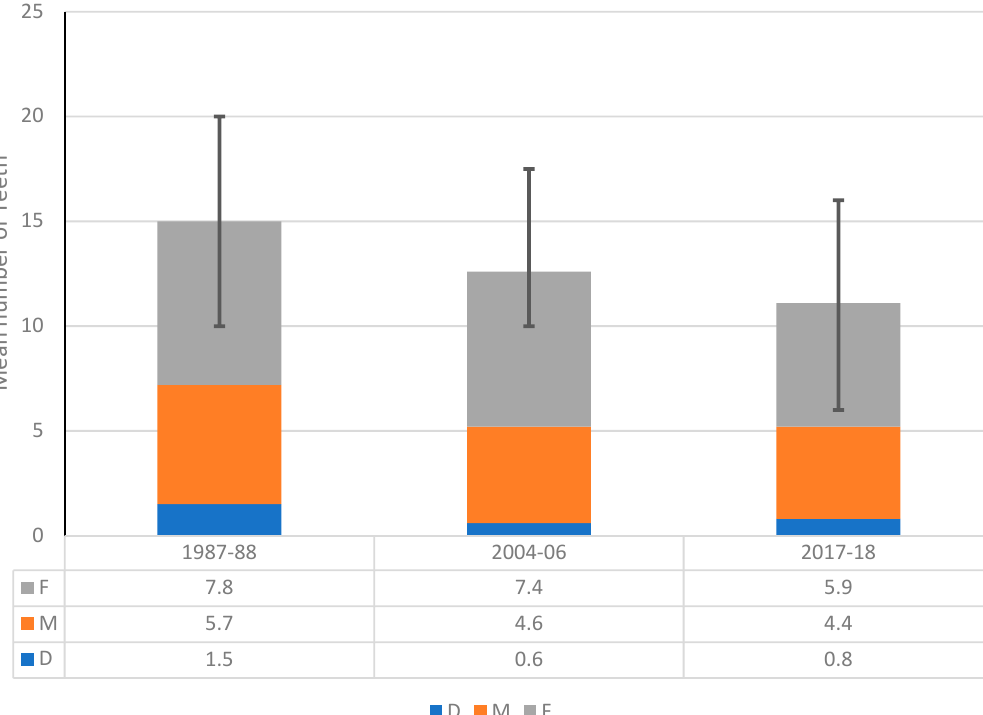
* Indicates a relative standard error of at least 25%, and hence should be interpreted with caution.